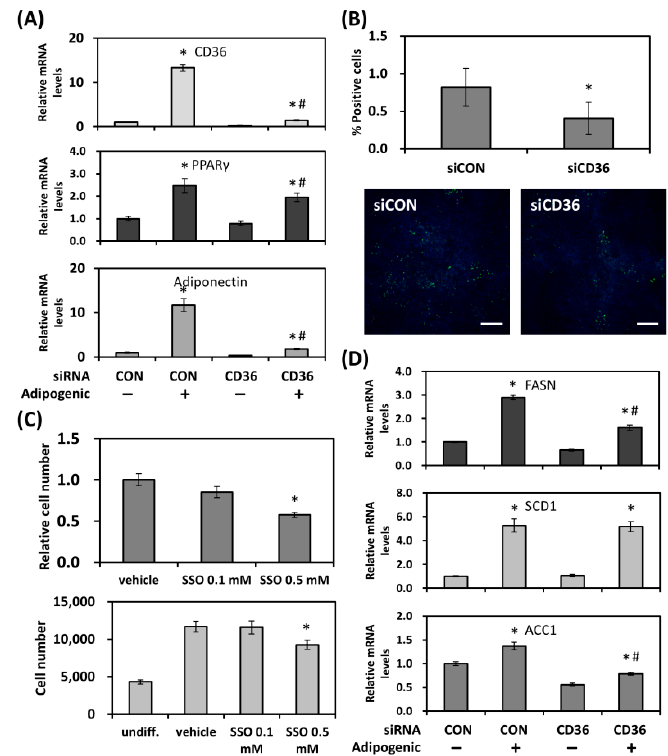
Figure 4. CD36 regulates adipogenesis. ( A ) Adipogenic markers were evaluated using quantitative RT-PCR in differentiated mouse 3T3-L1 cells transfected with control or CD36 siRNA. ( B ) As in ( A ), differentiated 3T3-L1 cells were stained with BODIPY 493/503 and counterstained with DAPI. Percent positive cells were determined by calculating the percentage of positively stained cells in all DAPI-stained cells. Scale bar: 500 µ m. ( C ) 3T3-L1 cells were induced for adipogenic differentiation in the presence of a CD36 inhibitor SSO. Cell viability and cell number were determined after three days. ( D ) Lipogenic gene expression was evaluated in differentiated 3T3-L1 cells transfected with control or CD36 siRNA. * Statistically significant compared with the control transfected, vehicle-treated group at p < 0.05; # statistically significant compared with the CD36 siRNA transfected, vehicle-treated group at p < 0.05.